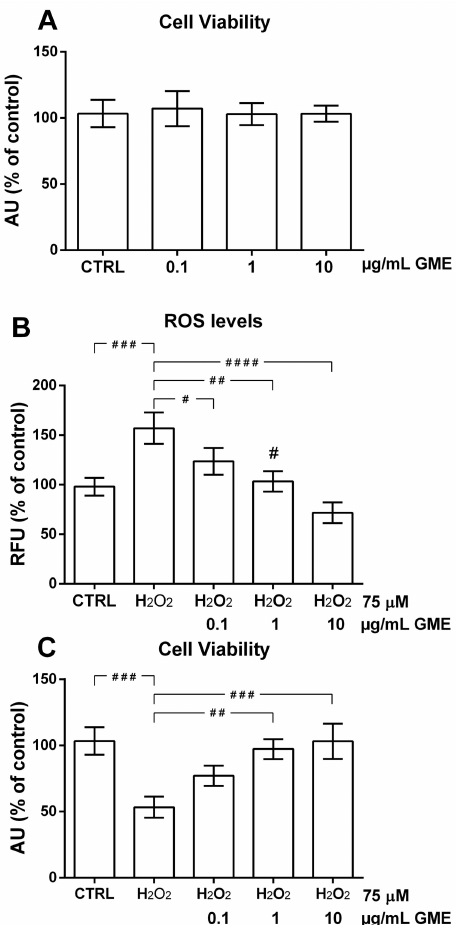
Figure 3. Effect of grape marc extracts on human umbilical vein endothelial cell (HUVEC) viability. ( A ) HUVECs were incubated for 20 h with the indicated concentrations of the extract, then cell viability was determined using the MTT assay, as reported in the materials and methods. Grape mark extract inhibits hydrogen peroxide (H 2 O 2 )-induced ROS generation in HUVECs. ( B ) HUVECs were exposed for 3 h to the indicated concentrations of grape marc extracts, and then incubated in the absence (CTRL) or presence of 75 µ M H 2 O 2 . Fluorescence was measured, as reported, in the Materials and Methods. #, p = 0.0428; ##, p = 0.0021; ###, p = 0.001; ####, p = 0.0001. Grape mark extract inhibits hydrogen peroxide (H 2 O 2 )-induced oxidative cell death of HUVECs. ( C ) HUVECs were exposed for 3 h to the indicated concentrations of grape marc extracts and then incubate for 20 h in the absence (CTRL) or presence of 75 µ M H 2 O 2 . Cell viability was assessed as reported in the materials and methods. Data are expressed as percentage of the control. CTRL, untreated cells; H 2 O 2 , hydrogen peroxide; GME, Grape marc extract. ##, p = 0.0017; ###, p =